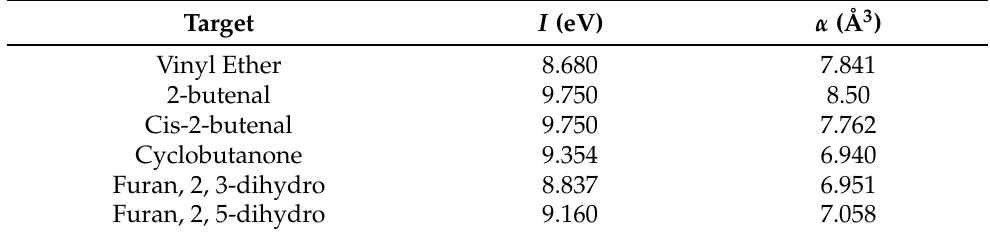
Table 1. The ionization energy ( I ) and polarizability ( α ) of the targets